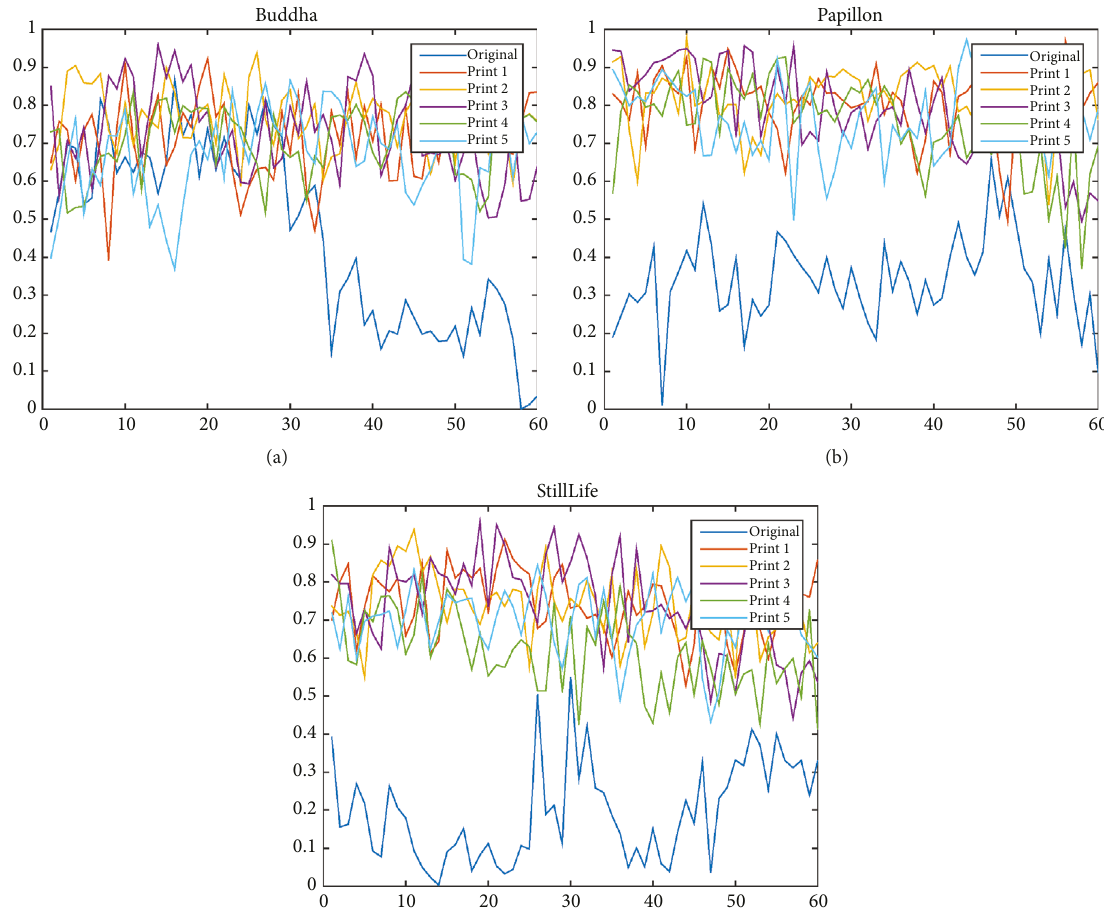
Figure 9: The energy ratio distribution for different light